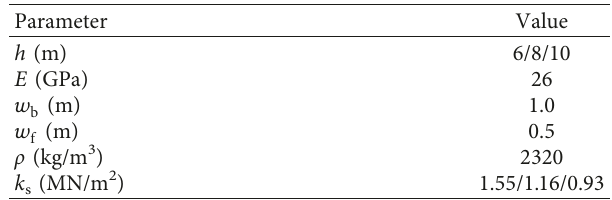
Table 1: Calculation parameters.